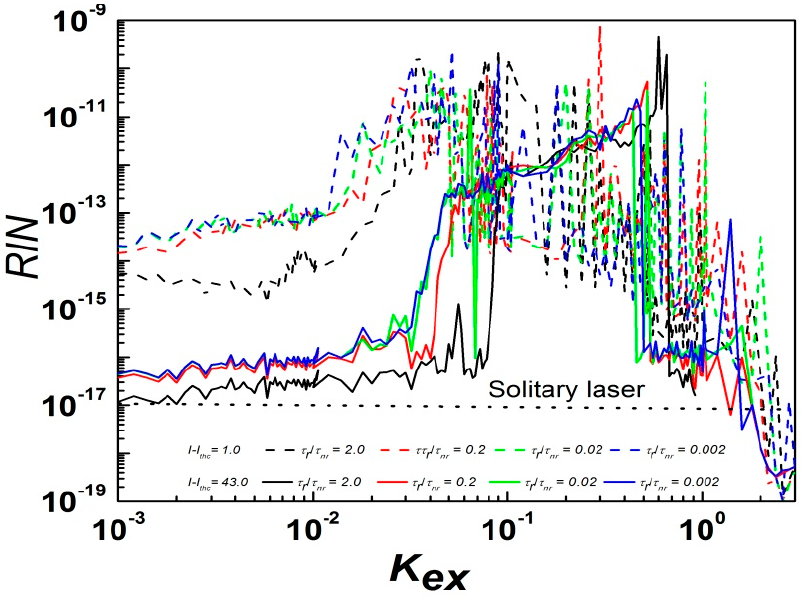
Figure 8. The low frequency of average RIN levels when f < 10 MHz, when I - I thc = 1.0 mA (dashed lines) and 43.0 mA (straight lines), and at τ r / τ nr = 2.0 (black), 0.2 (red), 0.02 (green), and 0.002 (blue).